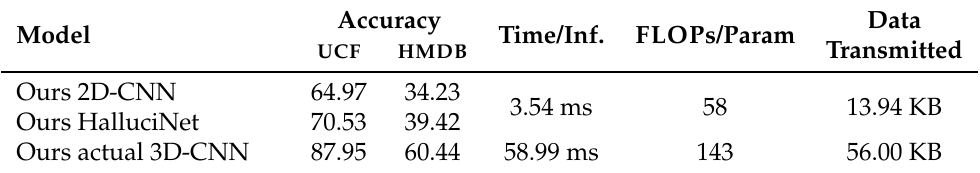
Table 2. Cost vs. accuracy comparison. We measure the times on a Titan-X GPU.